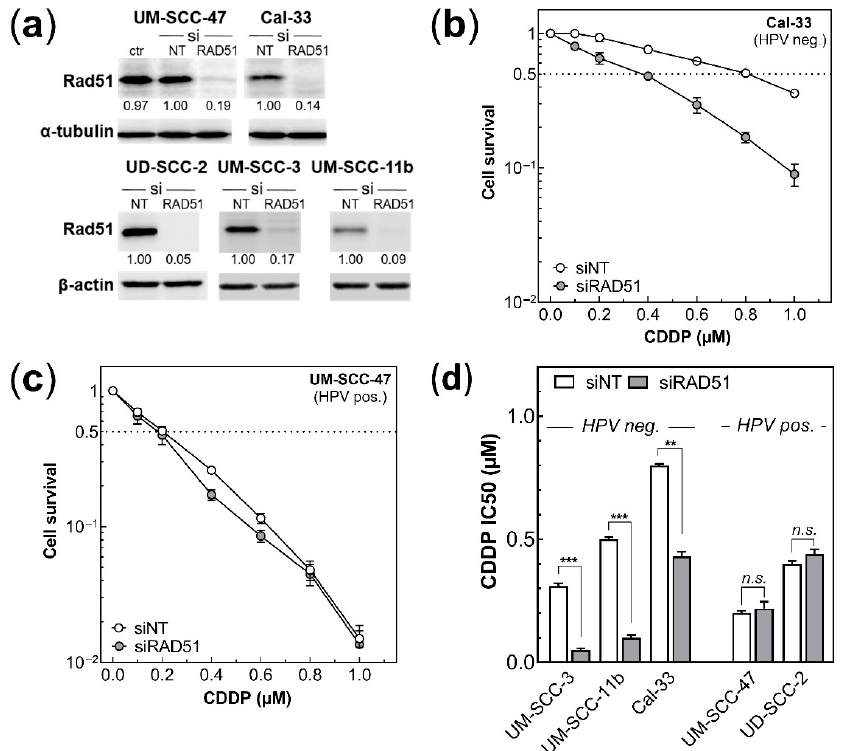
Figure 2. Effect of RAD51 KD on cisplatin sensitivity in HPV neg. and HPV pos. HNSCC cell lines. ( a ) RAD51 level 24 h after transfection with siRAD51 or siNT (non-target control) or native (ctr) cells; α -tubulin and β -actin were used as loading controls. ( b , c ) Cisplatin sensitivity of Cal-33 and UM-SCC-47 cells, with or without the knock-down of RAD51. Cells were treated with cisplatin (CDDP), as described in Figure 1. ( d ) Impact of RAD51 knock-down on IC50 of cisplatin, as determined for three HPV neg. and two HPV pos. HNSCC cell lines. Data are presented as mean values ± SEM, n ≥ 3, ** p = 0.001; *** p = 0.0001, n.s. : non significant.